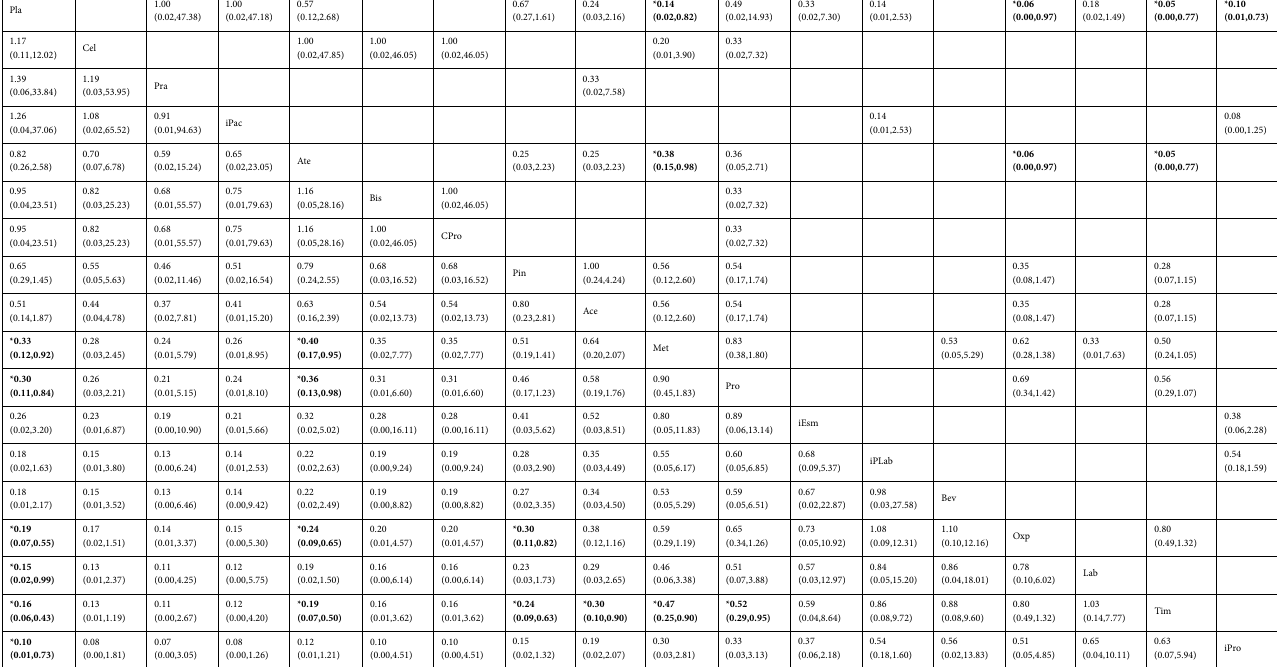
Table 3. League table of association between asthma exacerbation and beta-blocking agent prescription: patients with baseline asthma. Pairwise (upper-right portion) and network (lower-left portion) meta- analysis results are presented as estimate effect sizes for the outcome of asthma exacerbation incidence rate. Interventions are reported in order of mean ranking of incidence of asthma exacerbation, and outcomes are expressed as odds ratio (OR) (95% confidence intervals). For the pairwise meta-analyses, OR of less than 1 indicate that the treatment specified in the row got less incidence of asthma exacerbation than that specified in the column. For the network meta-analysis (NMA), OR of less than 1 indicate that the treatment specified in the column got less incidence of asthma exacerbation than that specified in the row. Bold results marked with * indicate statistical significance. Ace oral acebutolol, Ate oral atenolol, Bev oral bevantolol, Bis oral bisoprolol, Car oral carvedilol, Cat oral carteolol, Cel oral celiprolol, CI confidence interval, CPro oral celiprolol and propranolol, ES effect size, iEsm infusion of esmolol, iPac infusion of practolol, iPLab infusion of propranolol and labetalol, iPro infusion of propranolol, iSot infusion of sotalol, iTol infusion of tolamolol, Lab oral dilevalol or oral labetalol, Met oral metoprolol, Nad oral nadolol, NMA network meta-analysis, OR odds ratio, Oxp oral oxprenolol, Pin oral pindolol, Pla Placebo/control, Pra oral practolol, Pro oral propranolol, Sot oral sotalol, SUCRA surface under the cumulative ranking curve, Tim oral